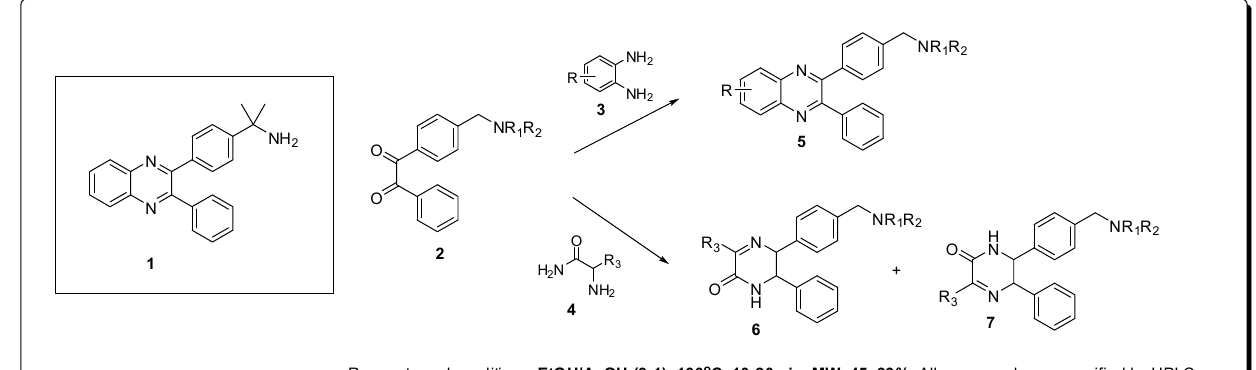
Figure 2. Synthesis of allosteric Akt kinase inhibitors with antineoplastic